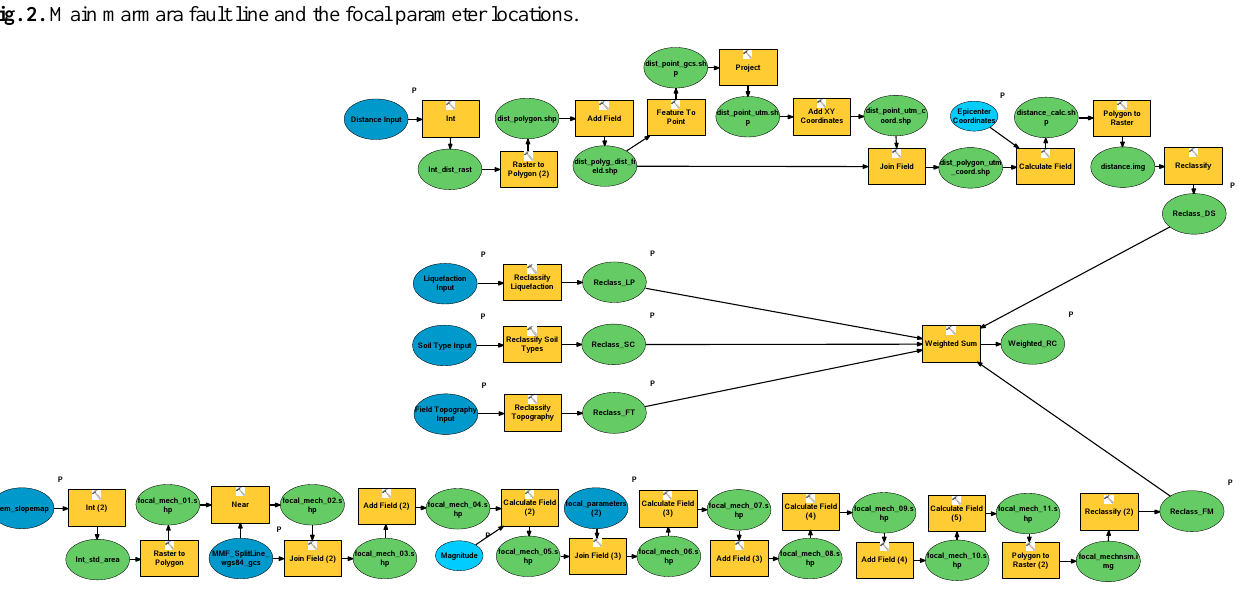
Fig. 3. Weighted Earthquake Sum model chart from the